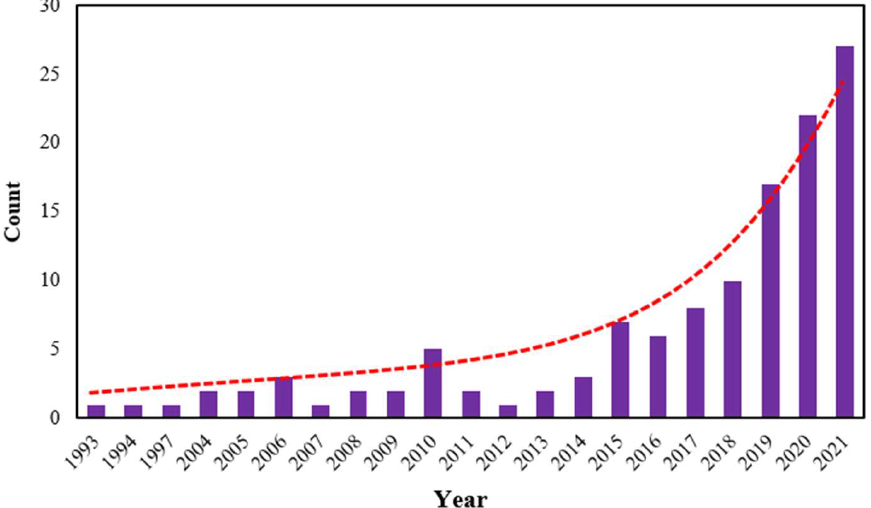
Figure 2. Number of manuscripts published in literature on application of NBs in flotation (from 1993 to 2021) (calculated based on the Web of Science data).